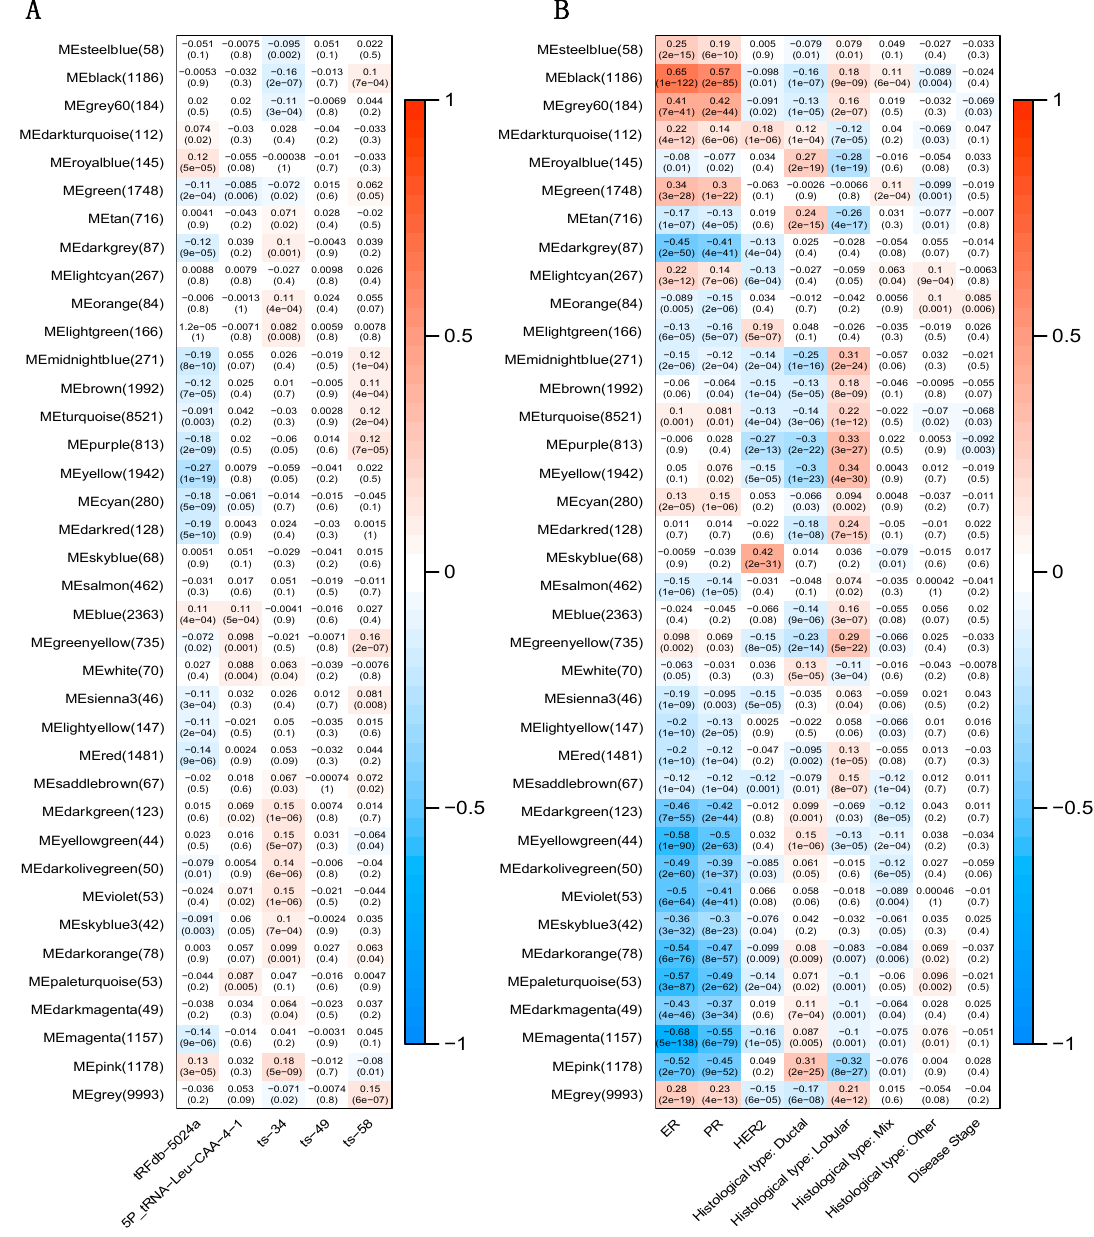
Figure 3. Correlation of gene modules with tRFs and clinical pathological variables. Row represents module eigengenes, column represents tRFs or clinical variables. Each cell displays the corresponding correlation coefficient and p -value. ( A ) Heatmap of correlations between module eigengenes and expression of the five tRFs. ( B ) Heatmap of correlations between module eigengenes and clinical variables.